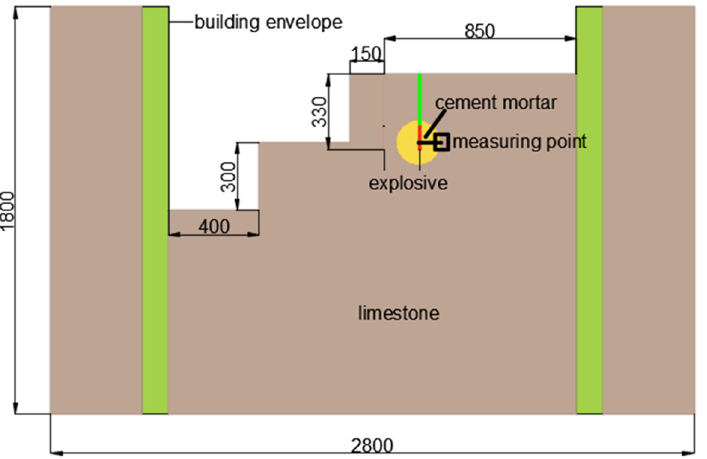
Figure 14. Geometric analysis model of the effect of cement mortar stiffness change on rock-break- ing effect.